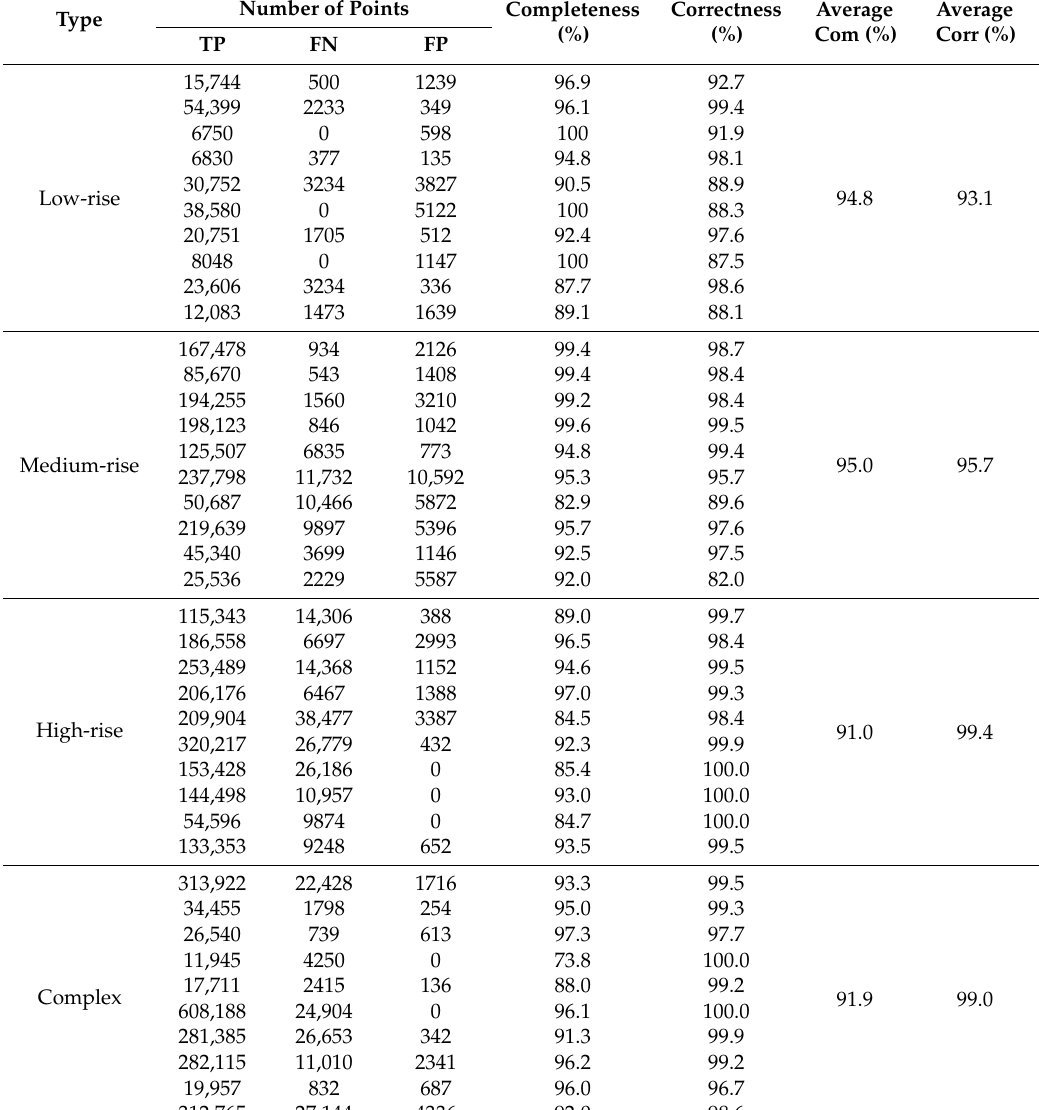
Table 3. Completeness and correctness of the extracted building